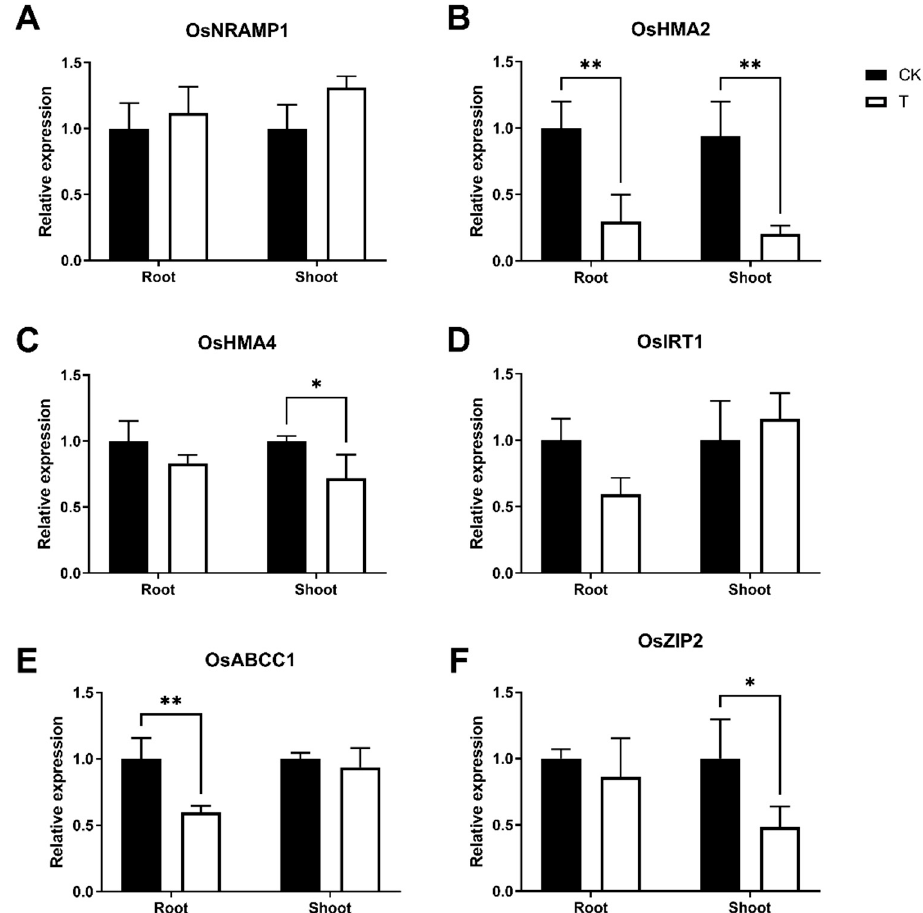
Figure 6. Relative expression of the transporter proteins OsNRAMP1 ( A ), OsHMA2 ( B ), OsHMA4 ( C ), OsIRT1 ( D ), OsABCC1 ( E ), and OsZIP2 ( F ) in Cd-N. (Values are mean with SD, n = 4, p value style is APA, ns: p > 0.05, *: p < 0.05, **: p < 0.01).